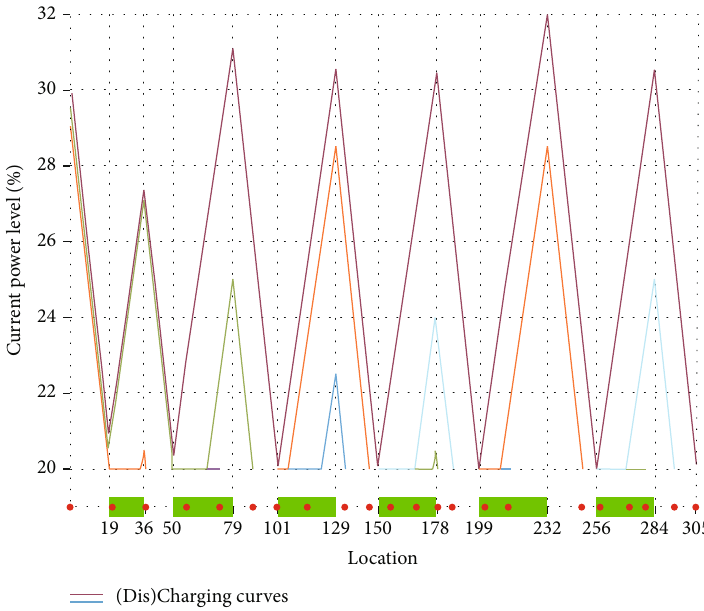
Figure 6: Minimum battery level for u .